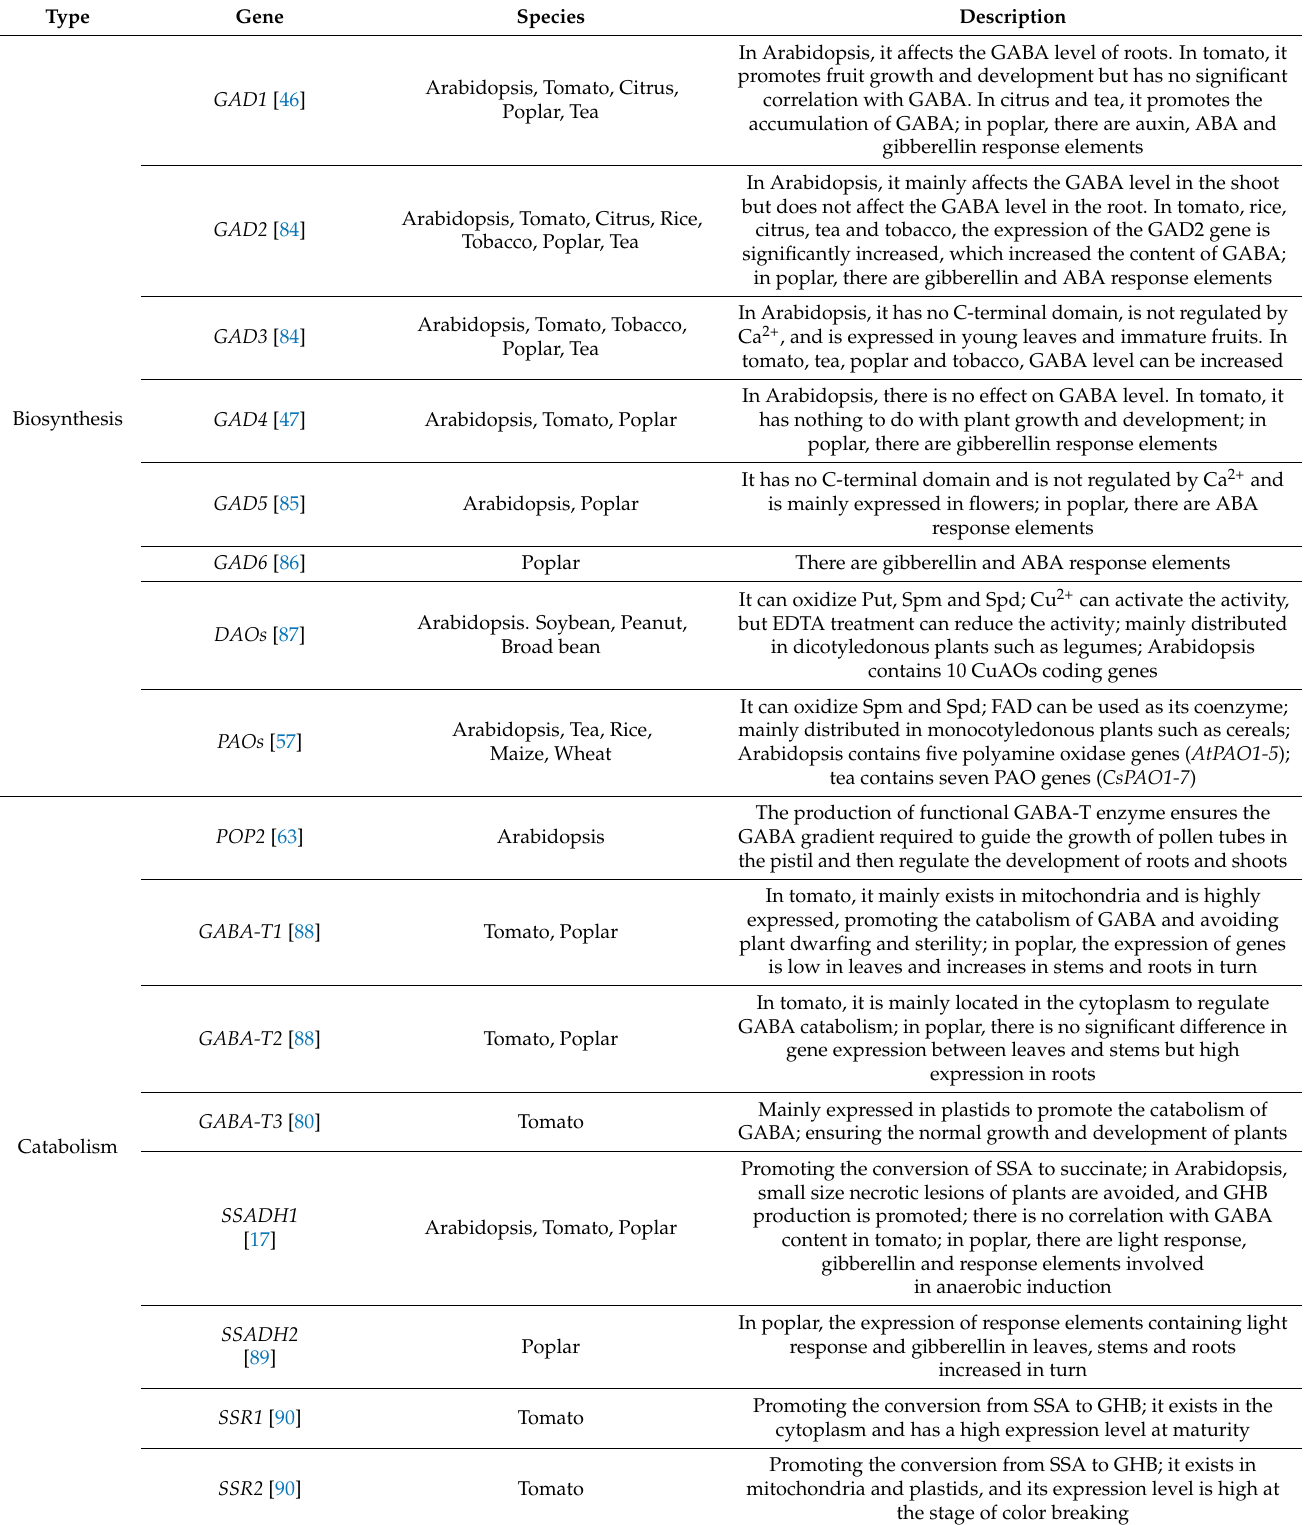
Table 1. Key genes in the biosynthesis and catabolism of GABA in